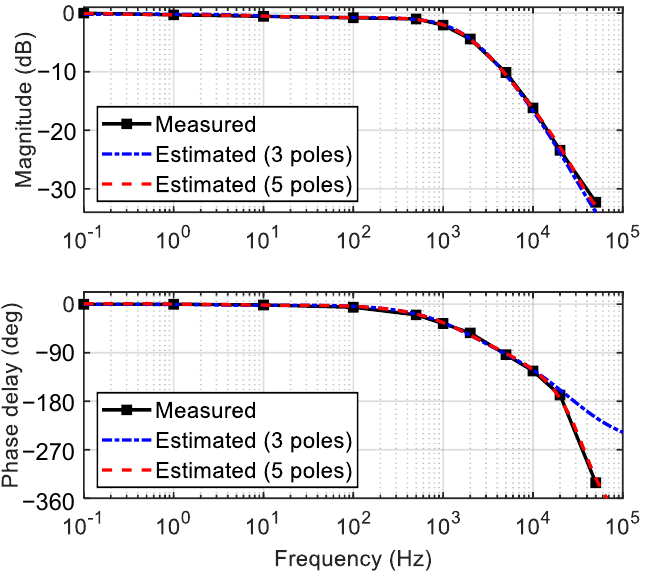
Figure 9. Bode plots reproduced by adopting the generalized Maxwell model incorporating three